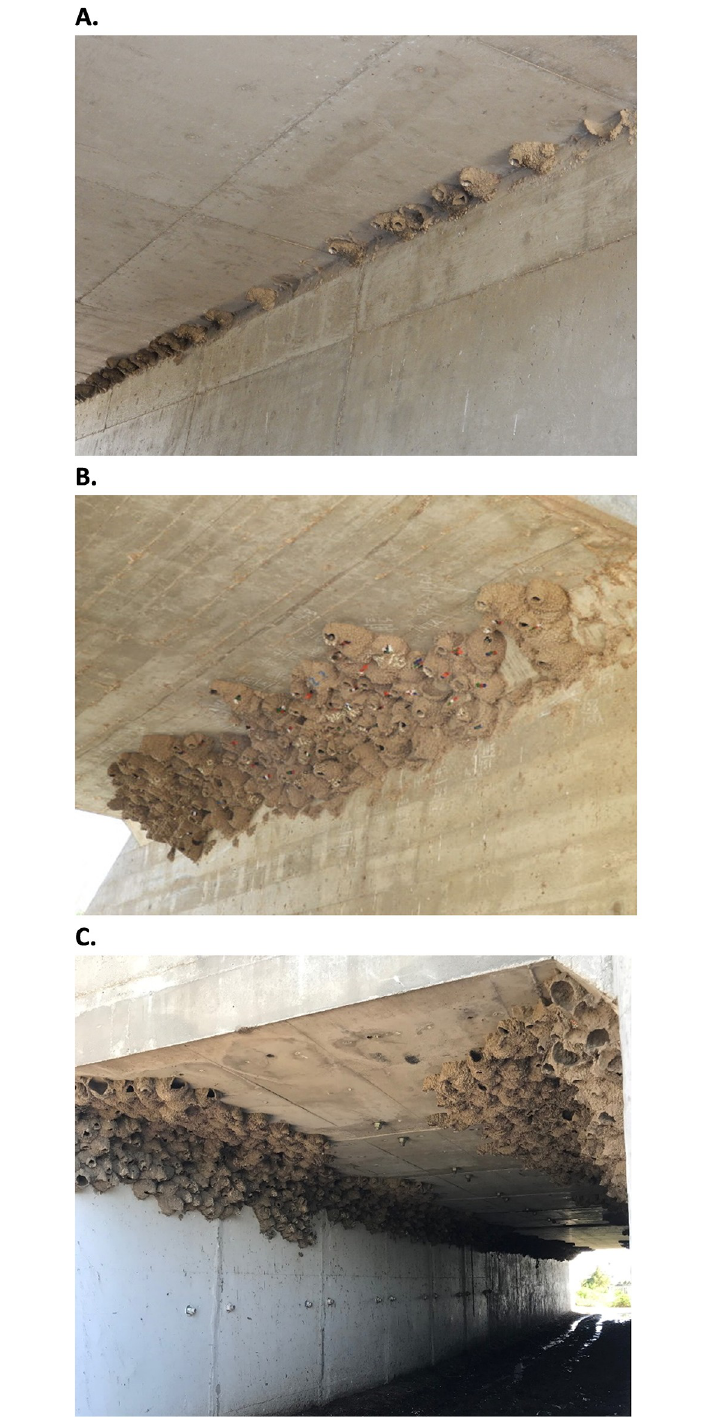
Fig 1. Comparison of nest density and extent of clustering at three colony sites of different colony sizes. (A) McDougals site versus the (B) CR-1 and (C) Junkyard sites.